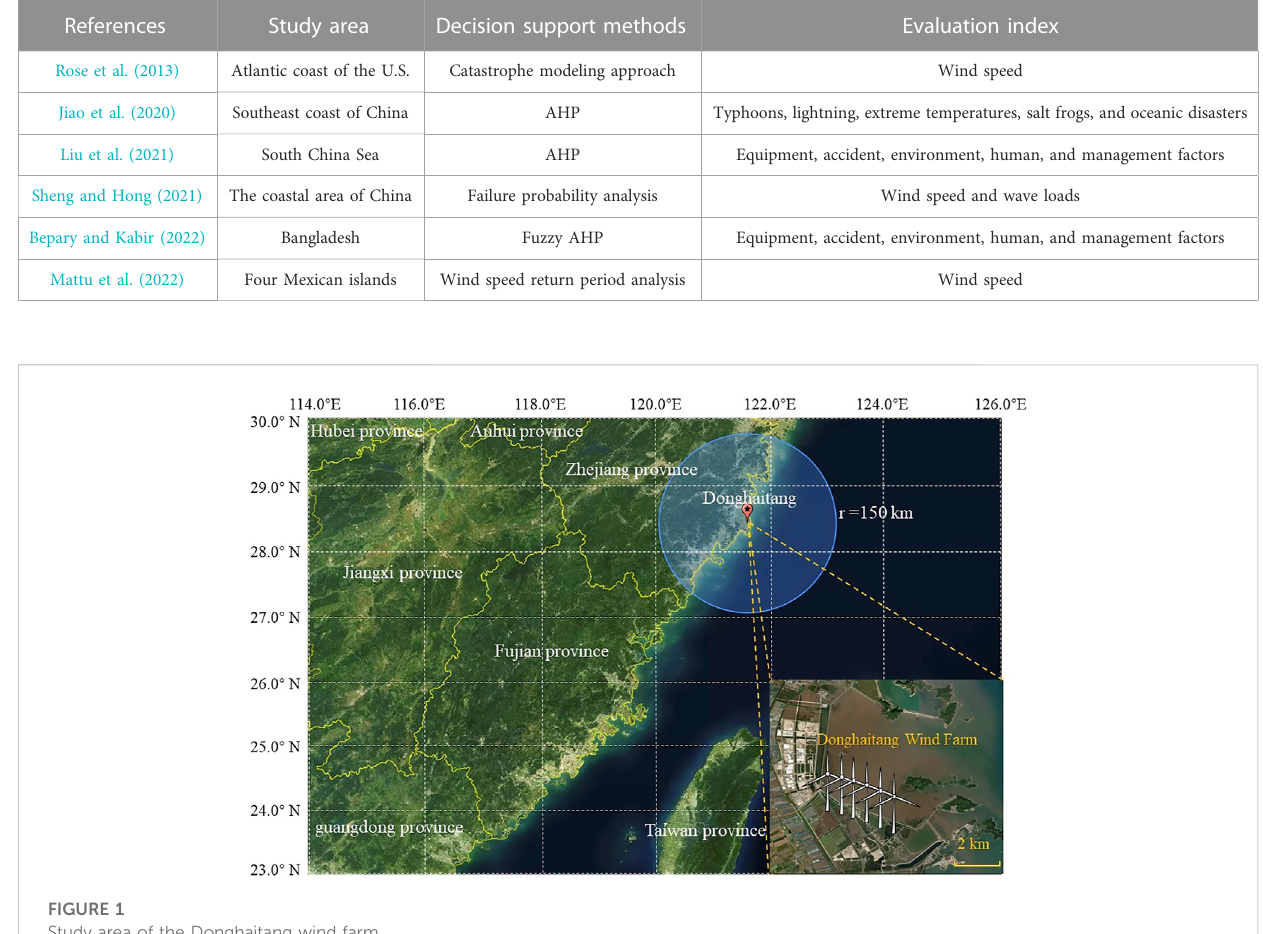
Study area of the Donghaitang wind